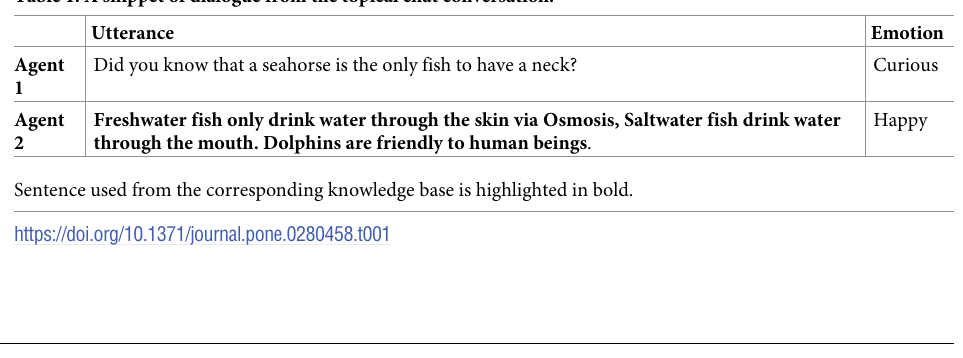
Table 1. A snippet of dialogue from the topical chat conversation. Utterance Emotion Agent Did you know that a seahorse is the only fish to have a neck? Curious 1 Agent 2 Sentence used from the corresponding knowledge base is highlighted in